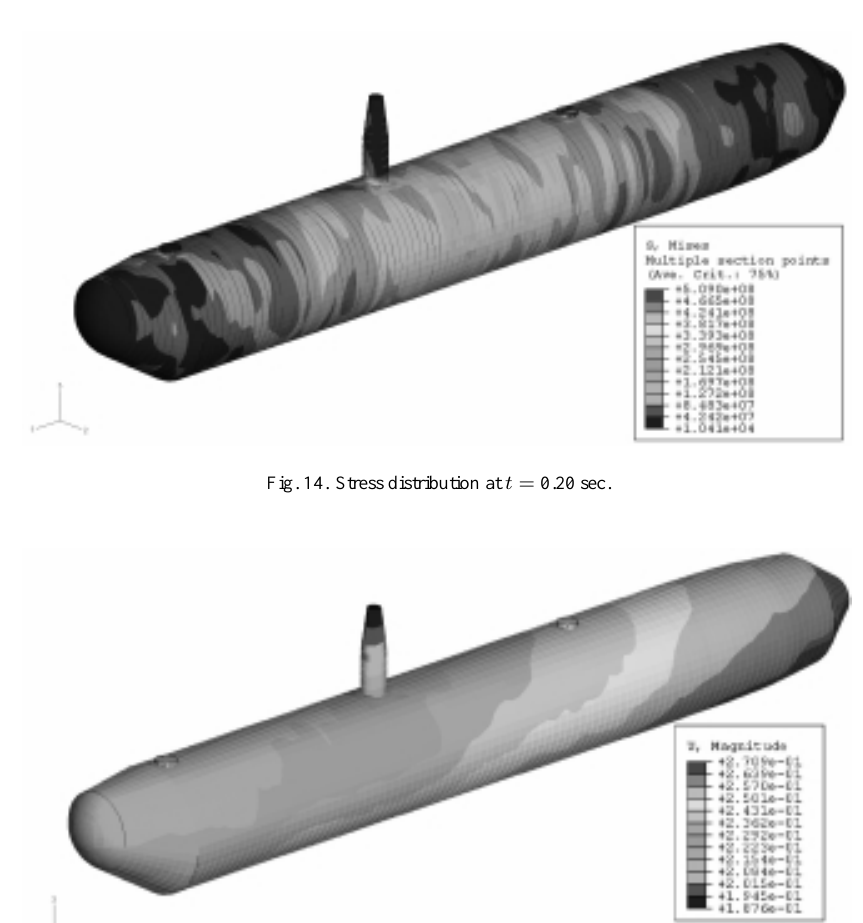
Fig. 13. Stress distribution at t = 0.12 sec.